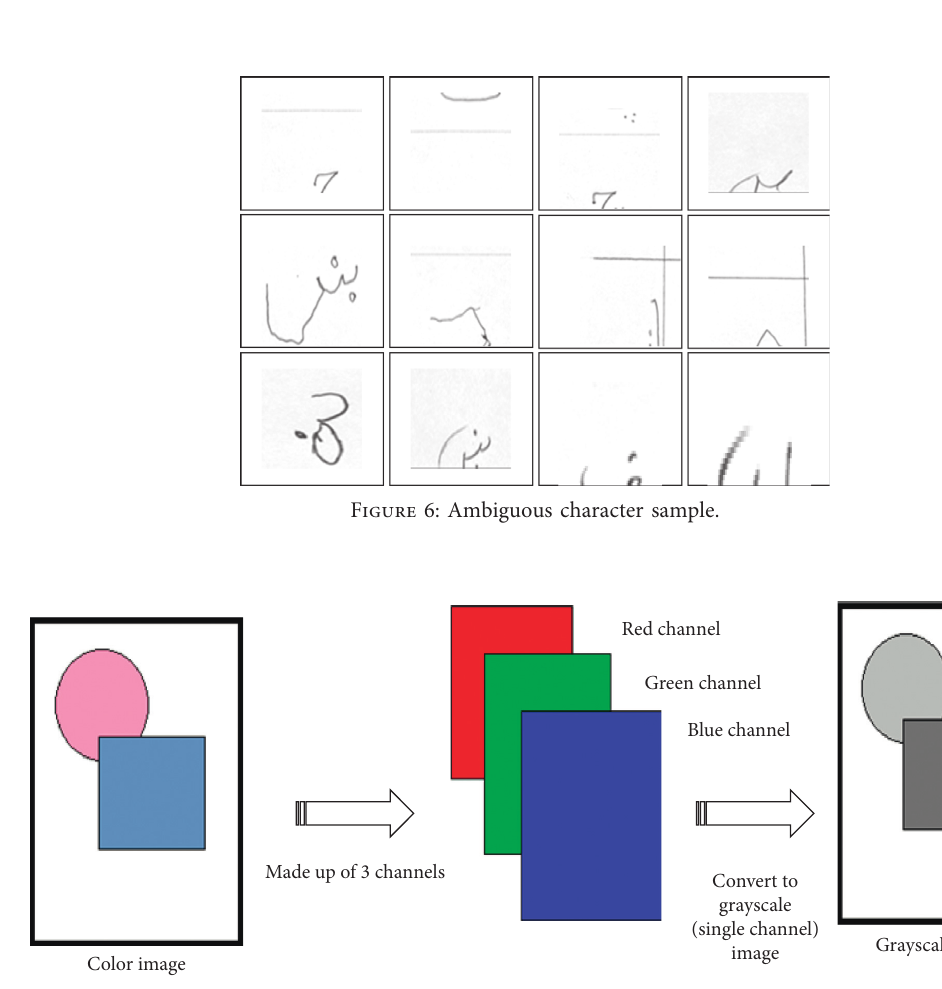
Figure 7: RGB channel representation.